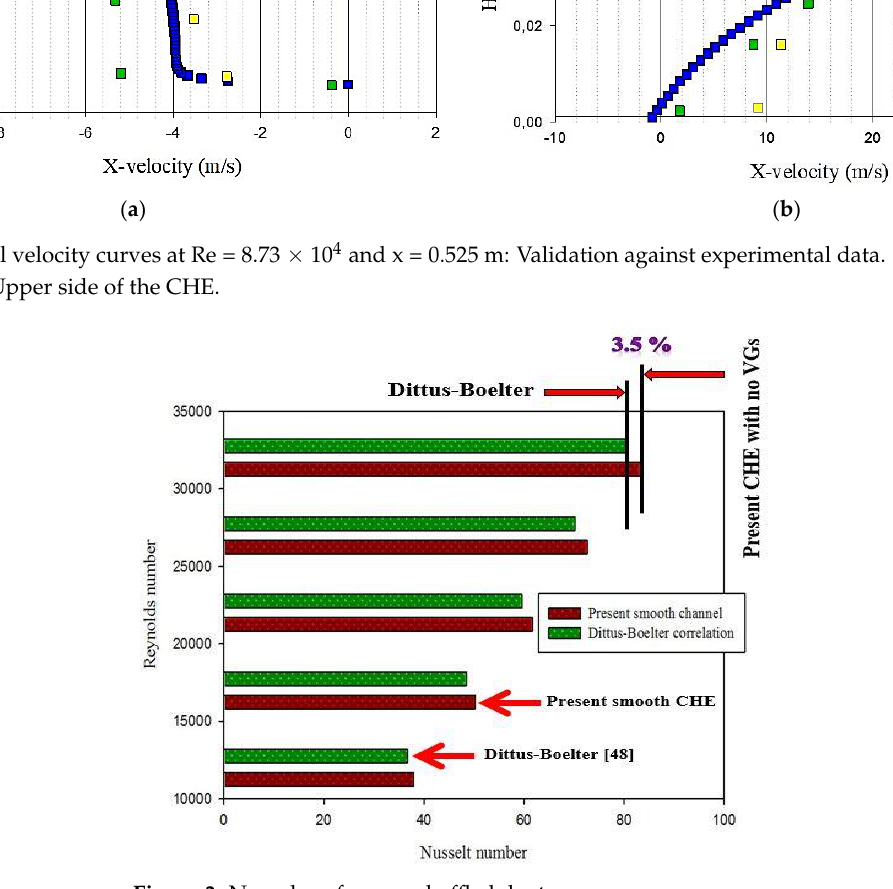
Figure 2. Axial velocity curves at Re = 8.73 × 10 4 and x = 0.525 m: Validation against experimental data. ( a ) Lower side of the CHE. ( b ) Upper side of the CHE